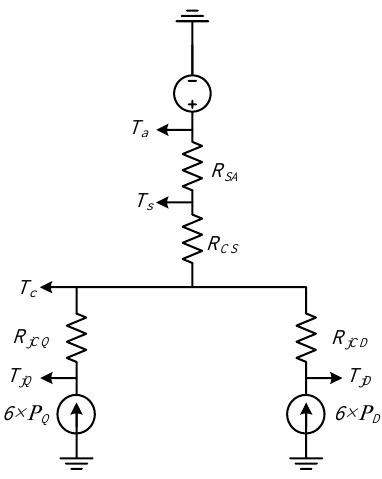
Figure 2. Thermal circuit with common thermal resistance case to heatsink.